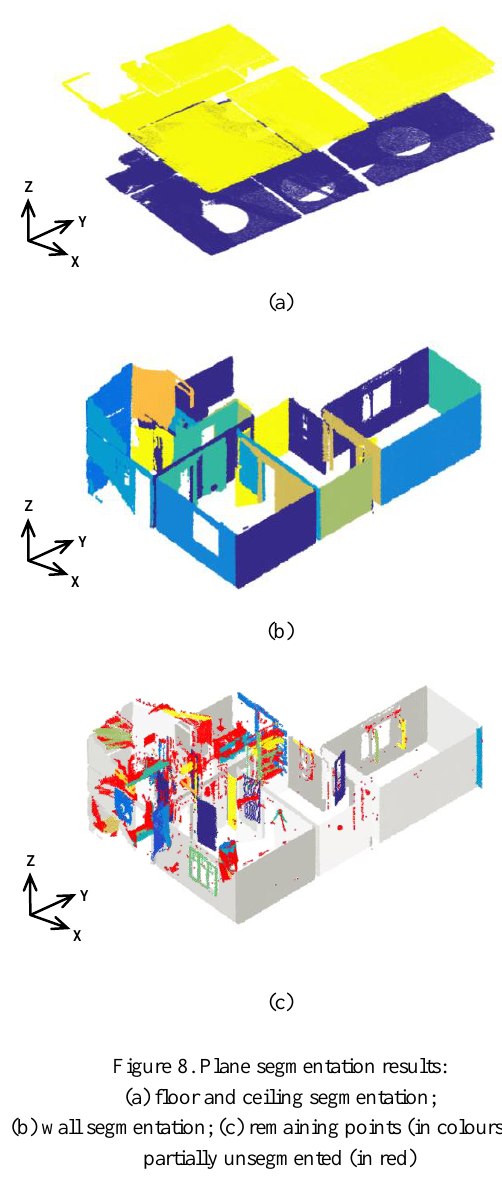
Figure 8. Plane segmentation results: (a) floor and ceiling segmentation; (b) wall segmentation; (c) remaining points (in colours) and partially unsegmented (in